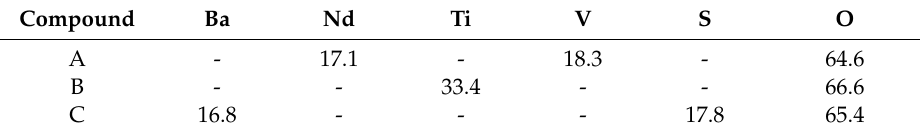
Figure 3. Surface morphologies of BaNd 2 Ti 3 O 10 pellet after hot corrosion in Na 2 SO 4 + V 2 O 5 molten salt at 900 °C for 4 h. ( a ) and ( b ) show the images with different magnifications. Table 1. Chemical compositions of compounds A–C in Figure 3 (in at.%).